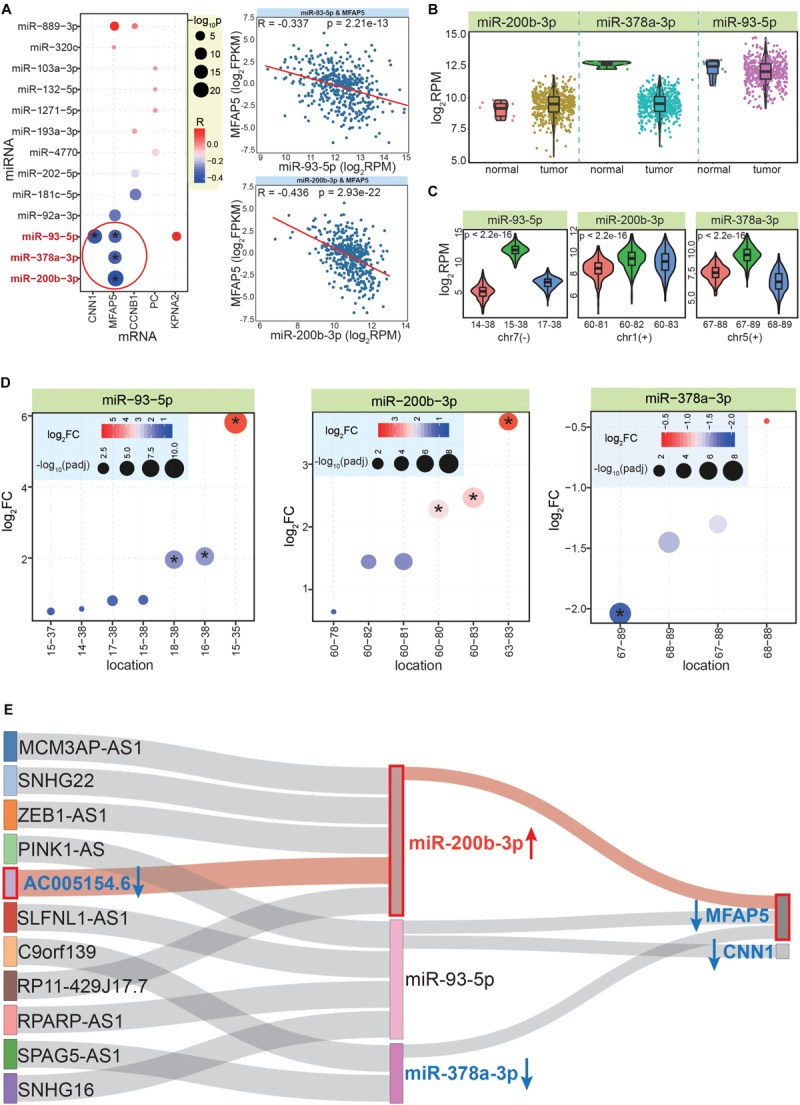
Further screening and identifying crucial ceRNA network. (A) The bubble plot shows co-expression correlations between mRNAs and related miRNAs; * indicates a significant negative correlation between the miRNA and mRNA pair. The images to the right show examples of the detailed expression patterns of the miRNAs and mRNAs. (B) The expression patterns between normal and CRC tumor samples for the three screened miRNAs. (C) Expression patterns of the most dominant three isomiRs in each miRNA locus; p values are estimated based on the Kruskal–Wallis test. The horizontal ordinate is the relative start and end point of each isomiR. (D) Differential expression patterns of multiple isomiRs in each miRNA locus. * indicates significantly abnormally expressed isomiRs (| log2FC| >1.5 and padj < 0.05). (E) Further analysis to identify crucial interactions in the ceRNA network, which reveals that the MFAP5-miR-200b-3p-AC005154.6 axis is a potential prognostic biomarker for CRC. Blue arrow shows decreased expression in CRC, red arrow shows increased expression. The MFAP5-miR-200b-3p-AC005154.6 axis is highlighted in pink.